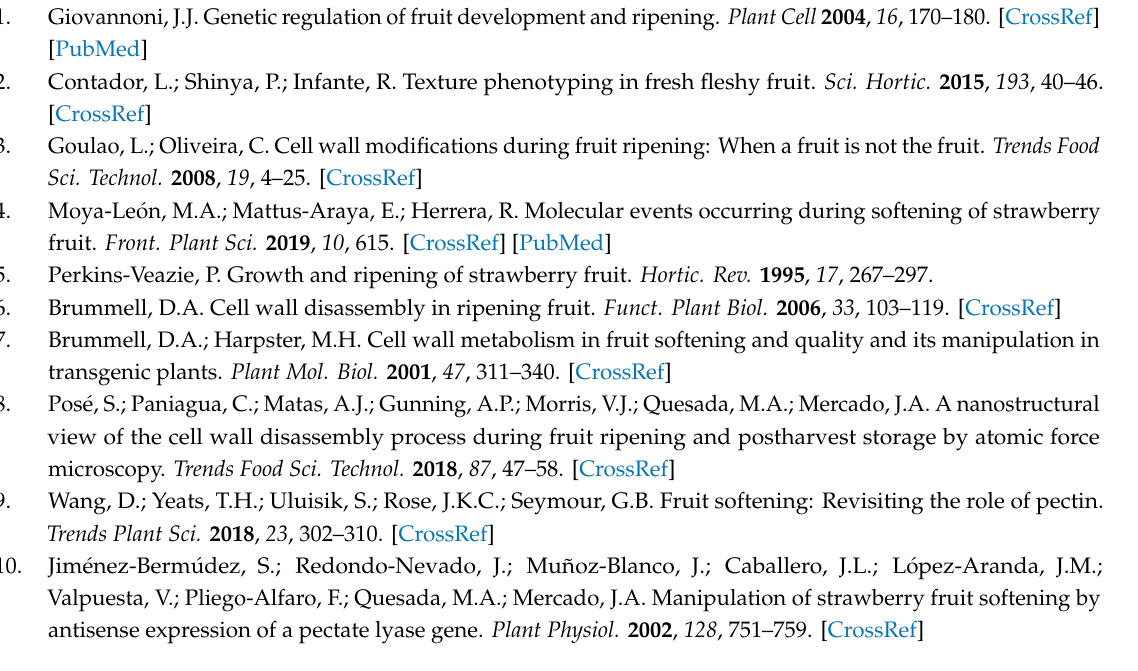
Figure S1: Variables factor map obtained in the PCA analysis of the whole set of carbohydrate microarray data. Table S1: List of monoclonal antibodies used in the carbohydrate microarray and the epitopes recognized by each